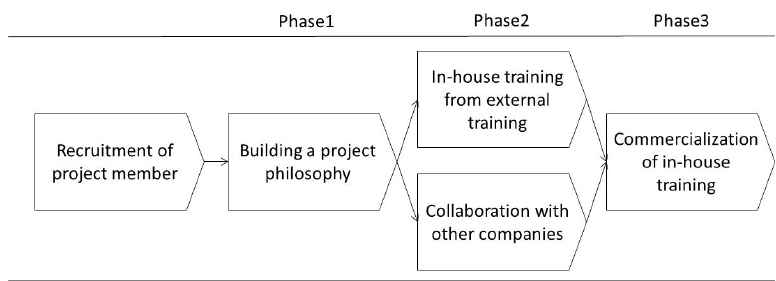
Figure 2. The project activity